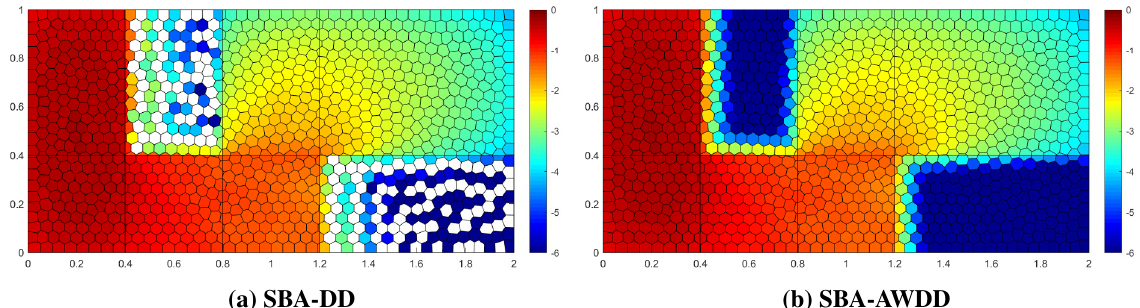
Figure 4: Example solutions plotted on a log scale of the SBA method using the (a) diamond closure and the (b) AWDD closure. White space indicates a cell with a negative